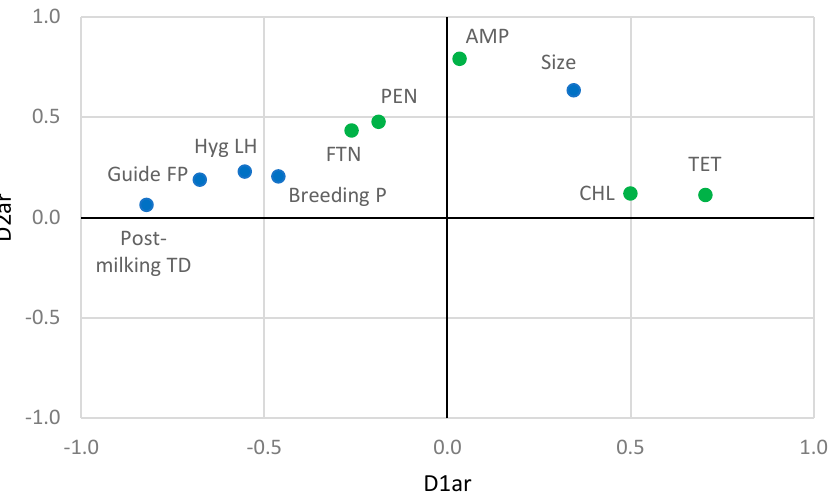
Figure 3. Nonlinear canonical correlation analysis similarity map determined by the first (D1am) and second dimension (D2am) for farming practices ( ● ) and biogenic amines ( ● ). Leyend: Breeding P = Breeding program, Guide FP = guide to good farming practices, Hyg LH = hygiene of the livestock